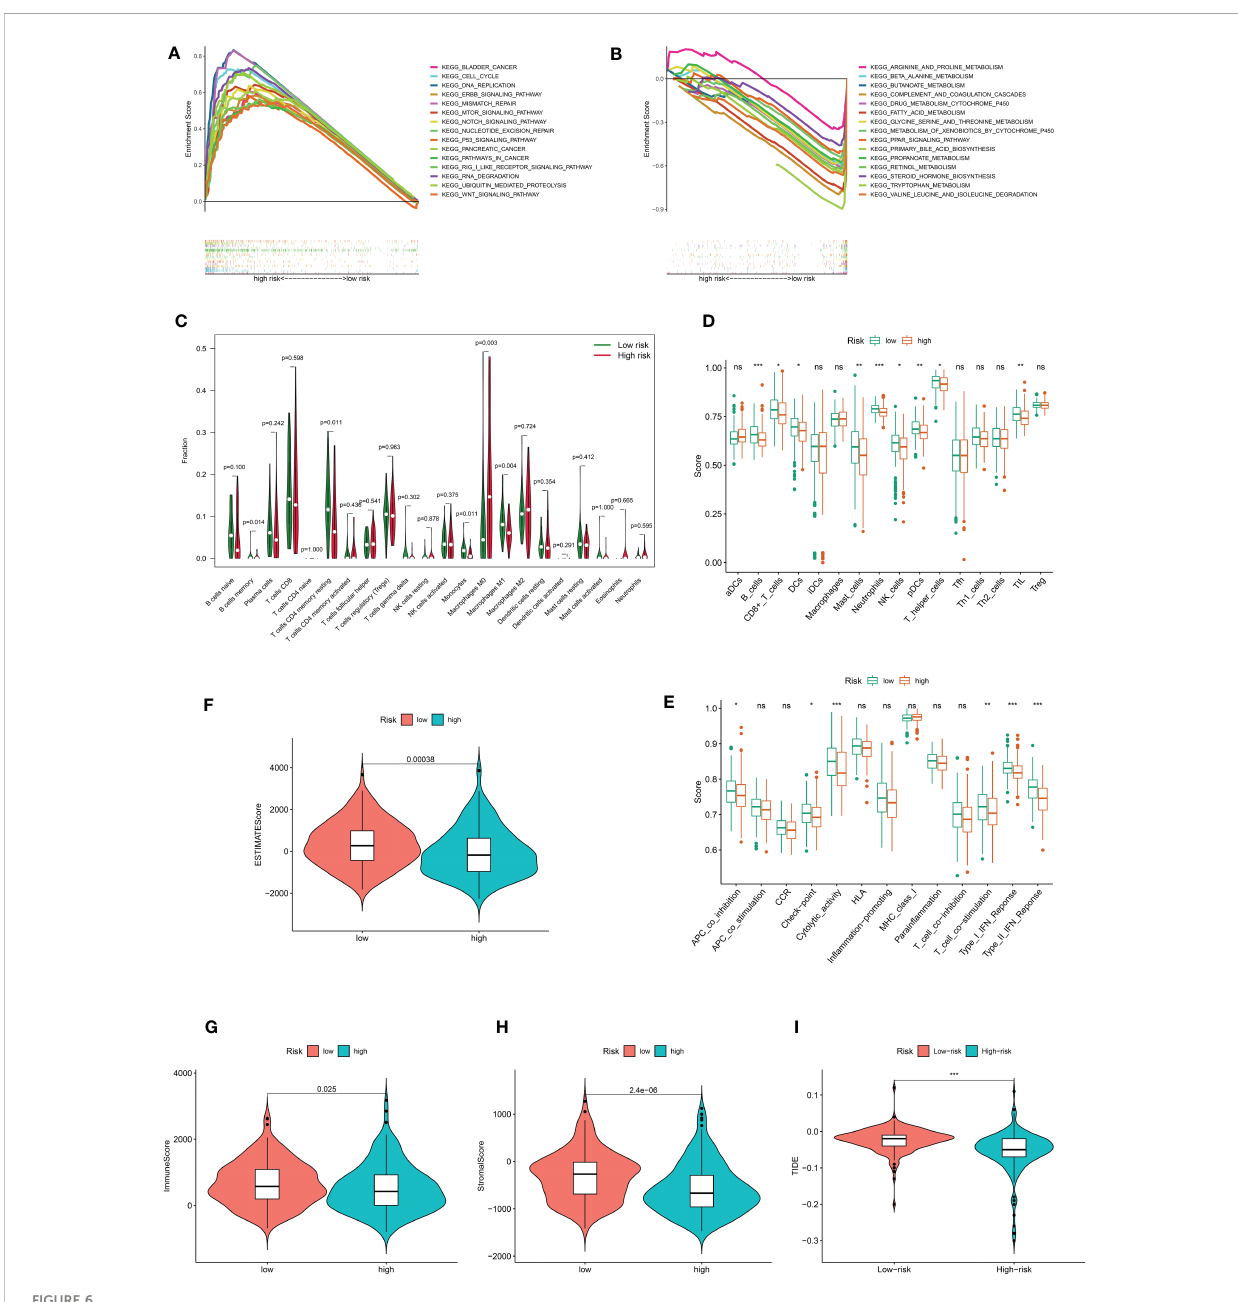
FIGURE 6 The immune landscape between high- and low risk- groups. Demonstrates that 15 representative KEGG pathways were signi fi cantly enriched in (A) high risk and (B) low risk groups, respectively. (C) Violin plot of 22 immune cell in fi ltrations based on the CIBERSORT algorithm. Immune cell scores (D) and immune function scores (E) in high- and low-risk groups based on ssGSEA algorithm. Comparison of estimate scores (F) , immune scores (G) , and stromal scores (H) between HCC patients in high- and low-risk groups. (I) Comparison of TIDE prediction scores between the high- and low-risk groups in the TCGA_LIHC dataset. *p<0.05, **p<0.01, ***p<0.001. no signi fi cant,